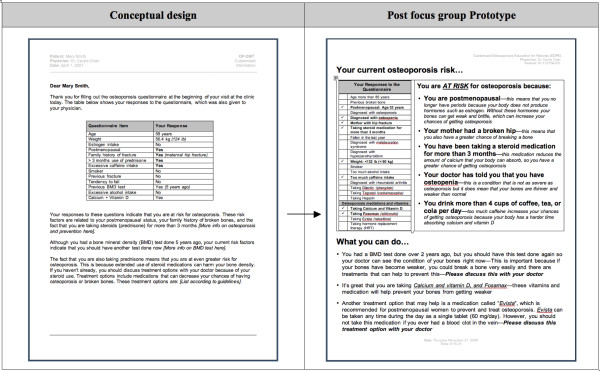
Screen shot of the evolution of the Customized Osteoporosis Education (COPE) sheet).